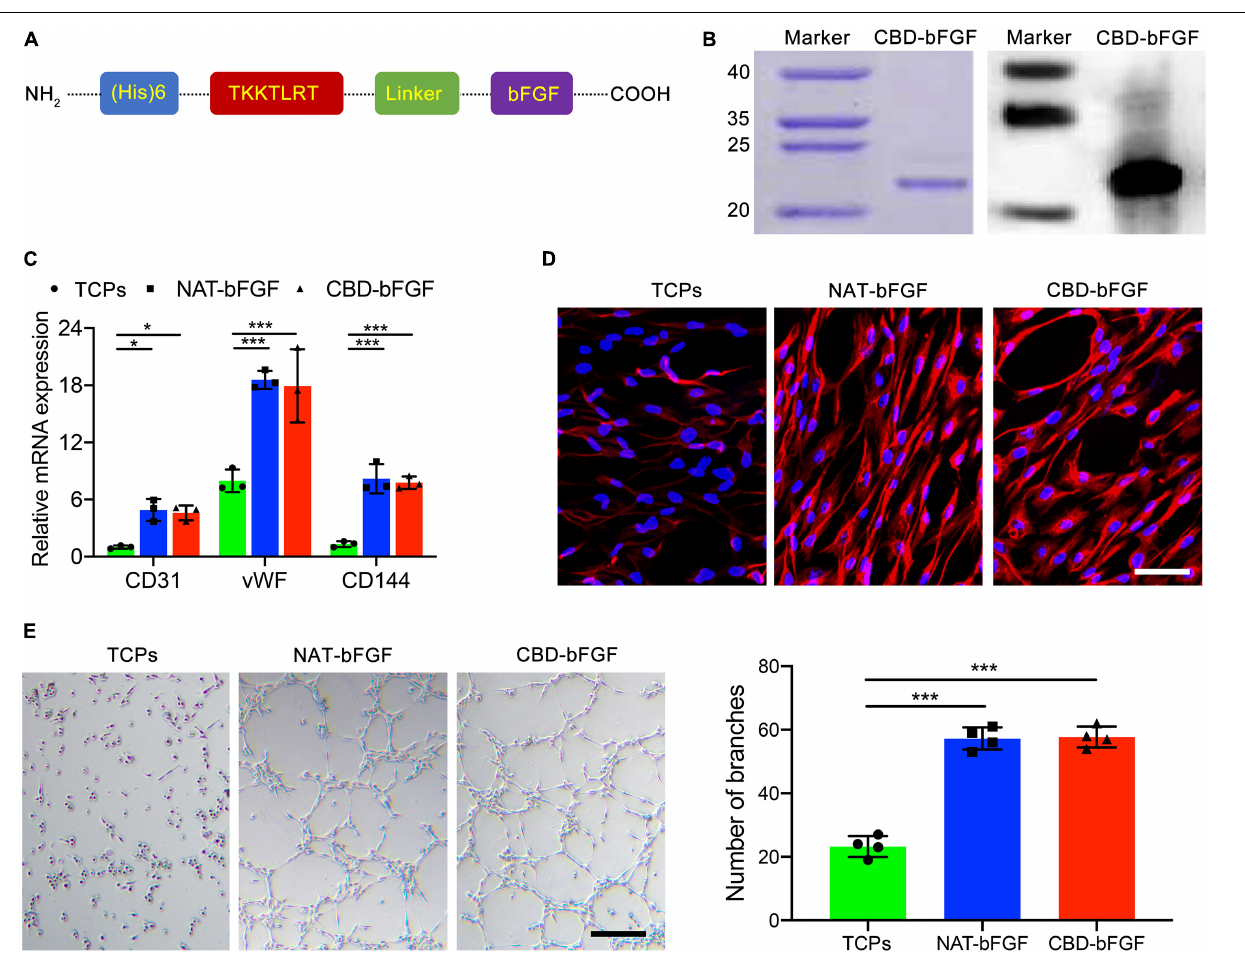
FIGURE 3 | (A) Schematic illustration of the full chemical structure of the collagen-binding domain–basic fibroblast growth factor (CBD–bFGF). (B) CBD–bFGF was identified by SDS-PAGE together with western blotting. (C) The expression of CD31, vWF, and CD144 in the adipose-derived stromal cells (ASCs) after having been induced by CBD–bFGF or natural (NAT)-bFGF for 10 days as evaluated using qRT-PCR. (D) The expression of CD31 in the ASCs after culturing with CBD–bFGF or NAT-bFGF for 10 days, stained with anti-CD31 antibody. Bar = 50 µ m. (E) Phase-contrast photomicrographs of the differentiated ASCs subsequently plated onto Matrigel for 12 h demonstrate more formation of capillary-like structures under the stimulation of CBD–bFGF and NAT-bFGF for 10 days. Bar = 100 µ m. Data are shown as means ± standard deviation (* P < 0.05, ** P < 0.01, and *** P <